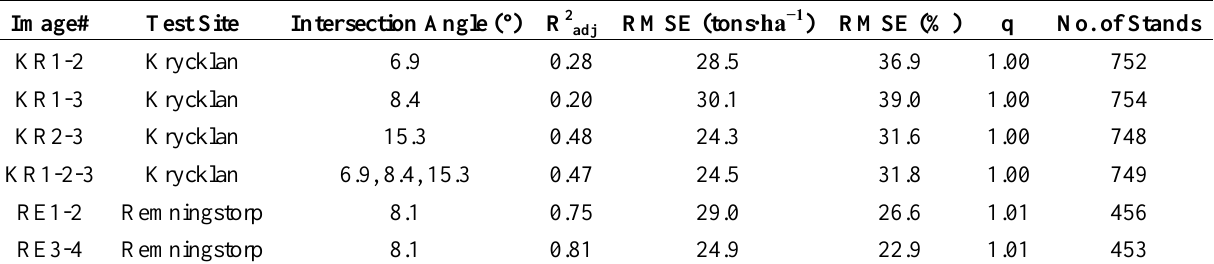
Table 4. The results for estimating AGB at both test sites.